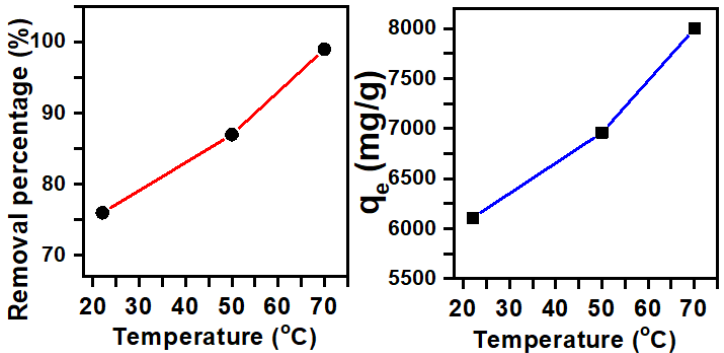
Figure 4. The removal efficiency of Fe 2 (MoO 4 ) 3 in a 80-ppm MB solution as a function of temperature (t = 30 min, pH = 11).